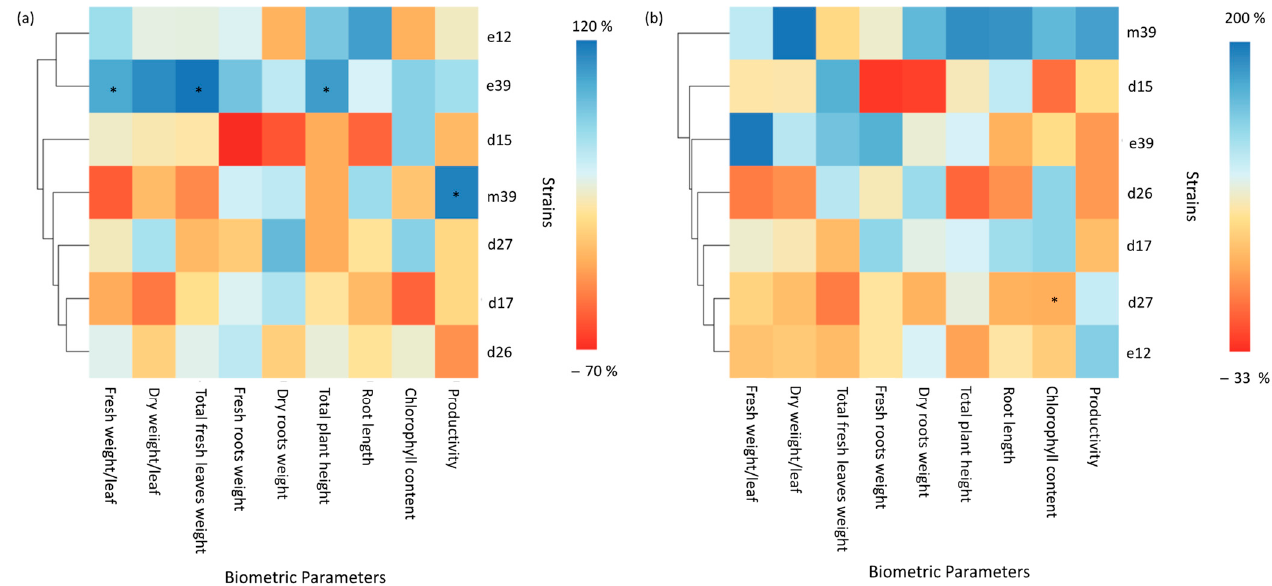
Figure 1. Biometric parameters of root-inoculated plants under no stress ( a ) or saline stress ( b ) conditions, expressed as percentage increase/decrease with respect to non-inoculated control. Data were collected 27 days post-bacterial inoculation. Color scale ranges from red (lower values than the control) to blue (higher values than the control). Asterisks indicate parameters significantly different from the control, according to Student’s t-test at p -value < 0.05.